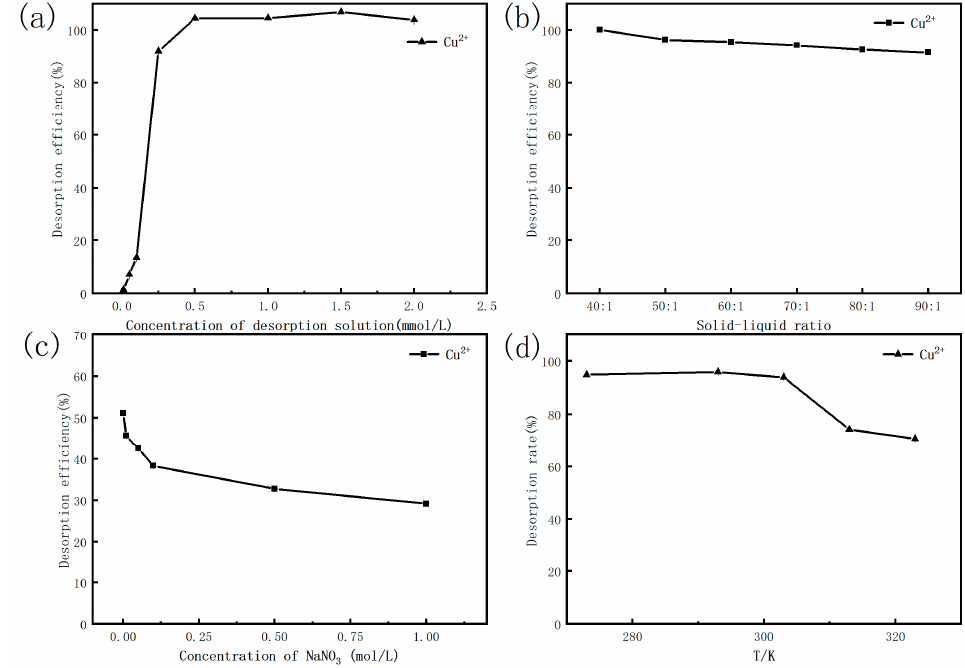
Figure 6. The effect of ( a ) concentration of desorbent (mol/L); ( b ) solid–liquid ratio; ( c ) ionic strength; and ( d ) temperature on the adsorption of Cu (II) by the MS. and ( d ) temperature on the adsorption of Cu (II) by the